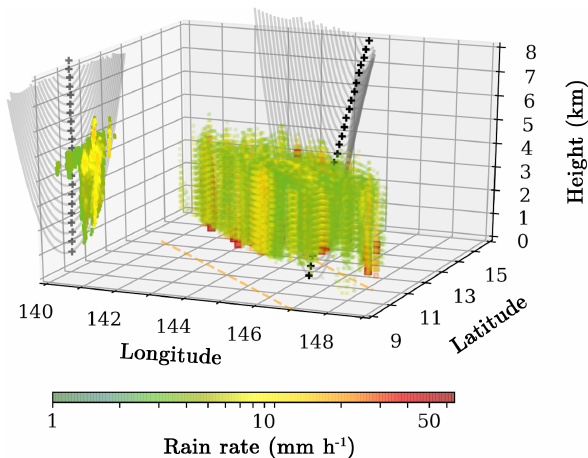
Figure 1. Three-dimensional collocation of an RO event with a TRMM PR precipitation measurement. It corresponds to the coin- cidence between the C004.2006.329.22.20.G19 RO event and the 2B31.20061125.51450 TRMM PR product. Here, the precipitation structure is shown in a three-dimensional grid, along with the set of RO ray trajectories (in gray). Black stars indicate the tangent point of the rays. Only a few rays are shown for illustration purposes. The orange dashed lines indicate the edges of the TRMM PR swath. The precipitation information (rain rate) interpolated into the RO plane is shown in the two-dimensional projection in the latitude–height